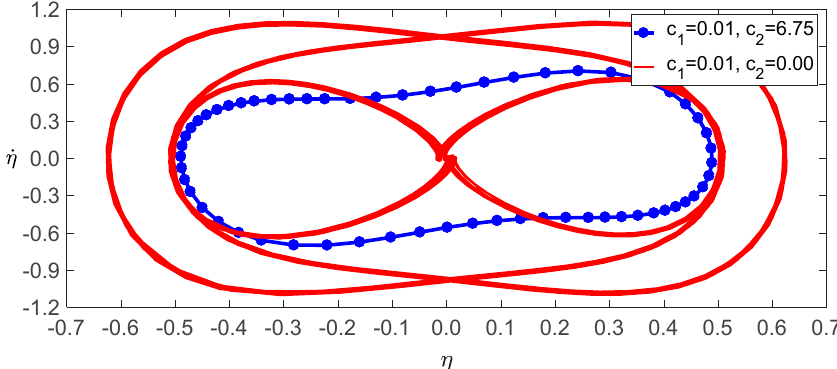
1.5 and = 10 f . Figure 3. The phase portraits of non-resonant excitations for Ω 1 = 1.5 and f 1 = 10. 1 1